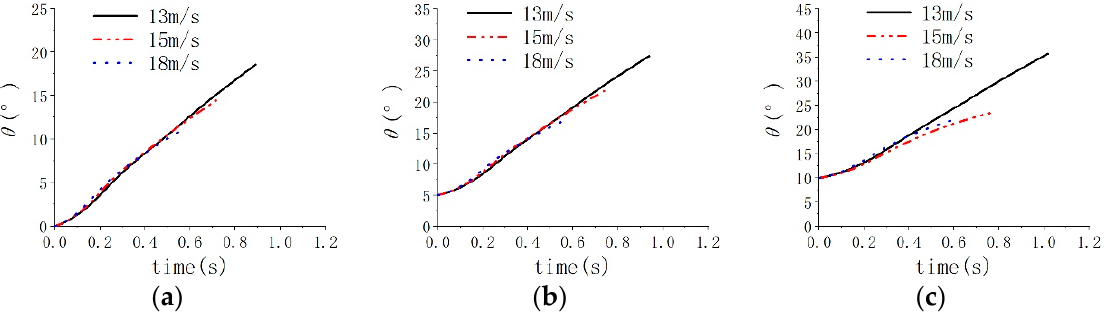
Figure 18. Images of axial velocity variation of vehicles under di ff erent initial velocities. ( a ) Axial velocity of vehicle in case 1, 4, 7. ( b ) Axial velocity of vehicle in case 2, 5, 8. ( c ) Axial velocity of vehicle in case 3, 6, 9.